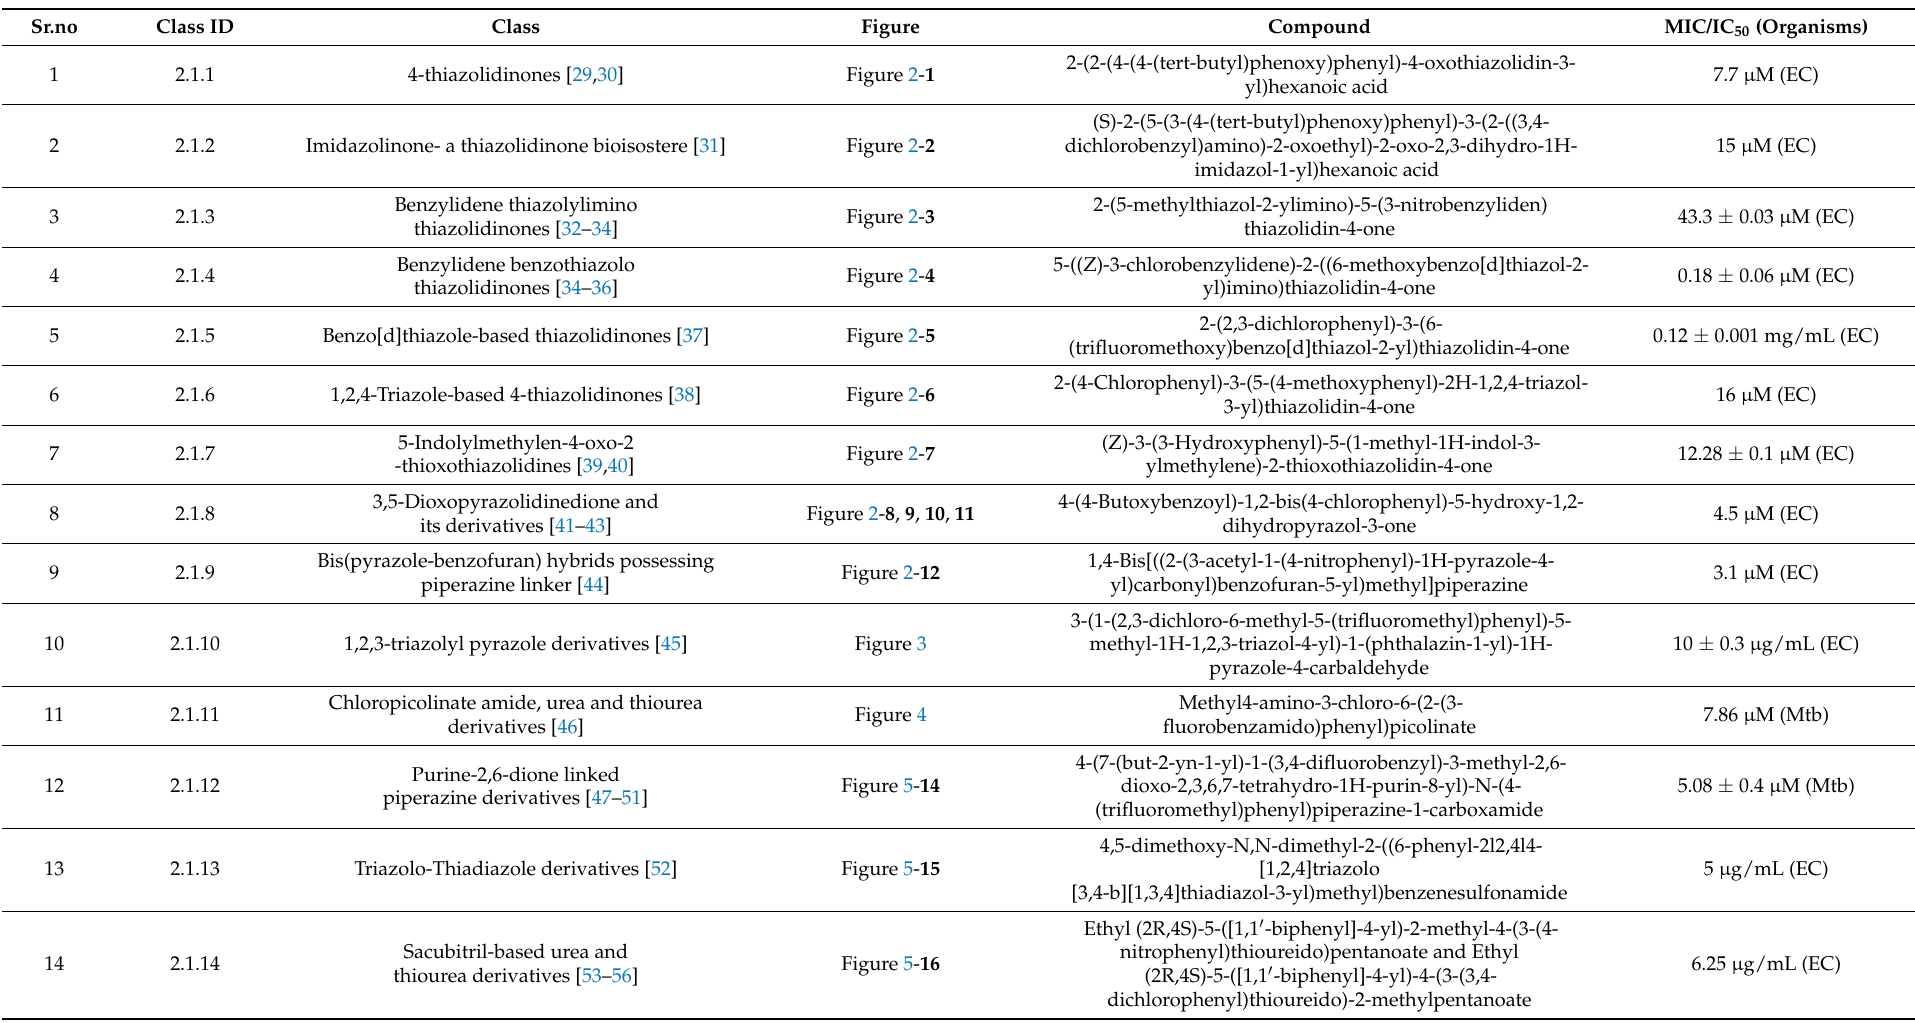
Table 3. Comparative summary of the most potent analogs of the classes discussed in earlier